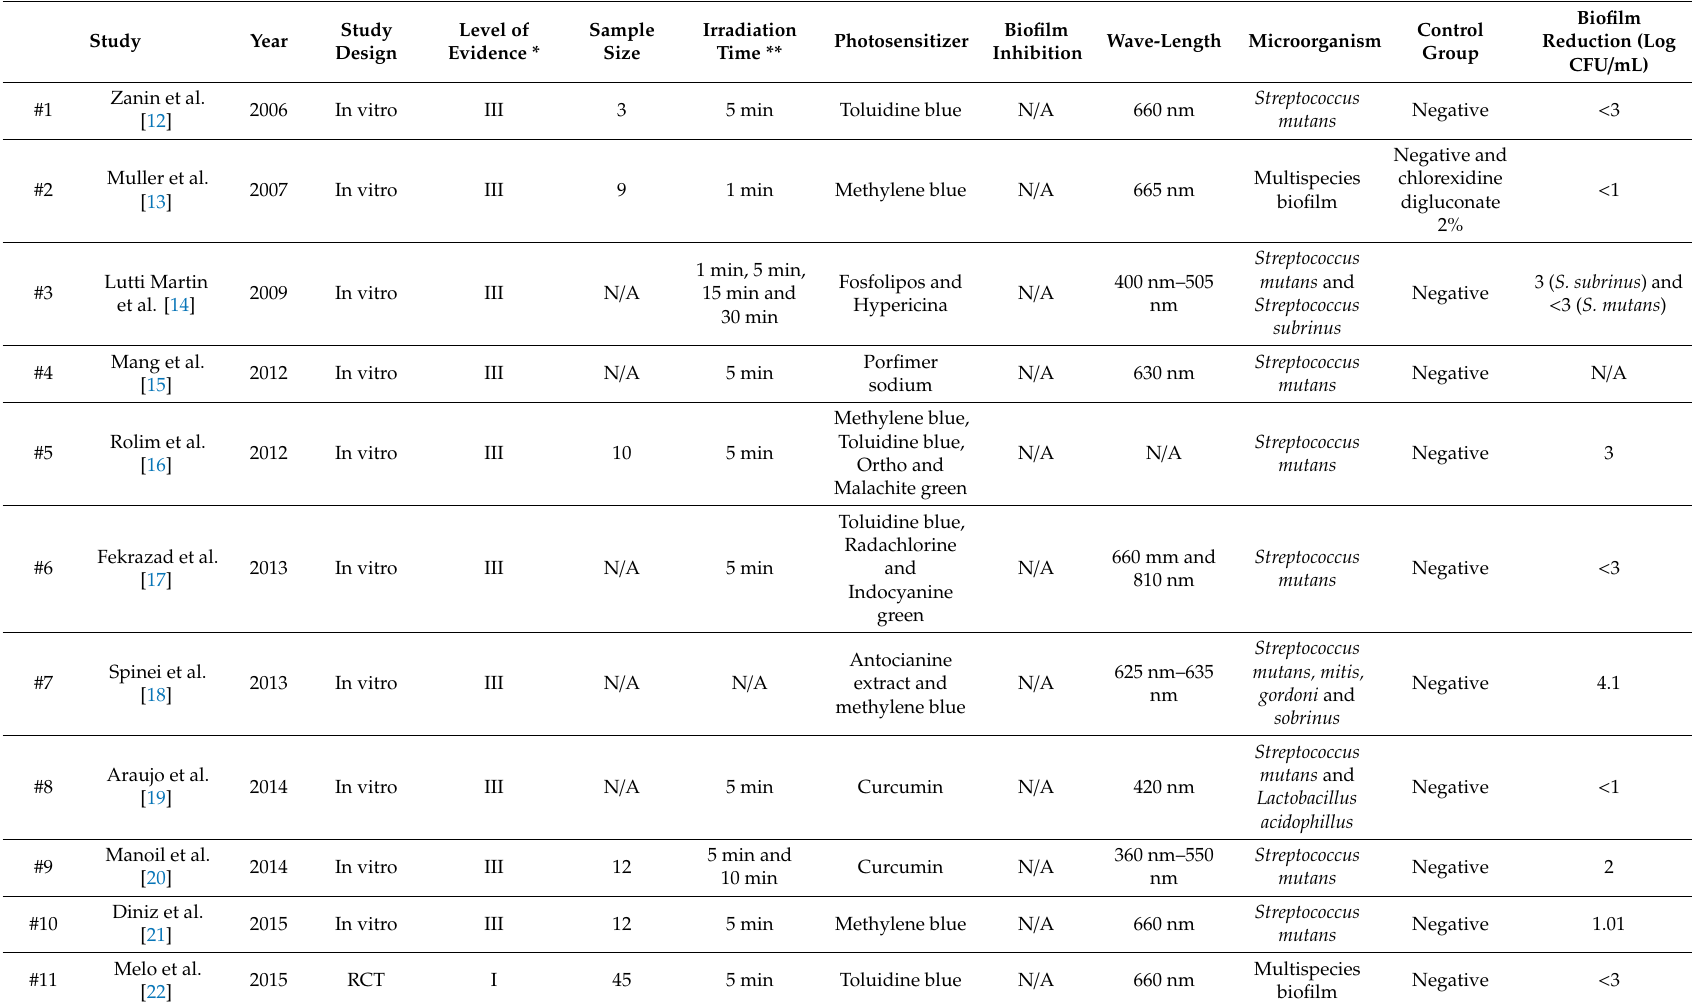
Table 1. Summary of the characteristics of the included